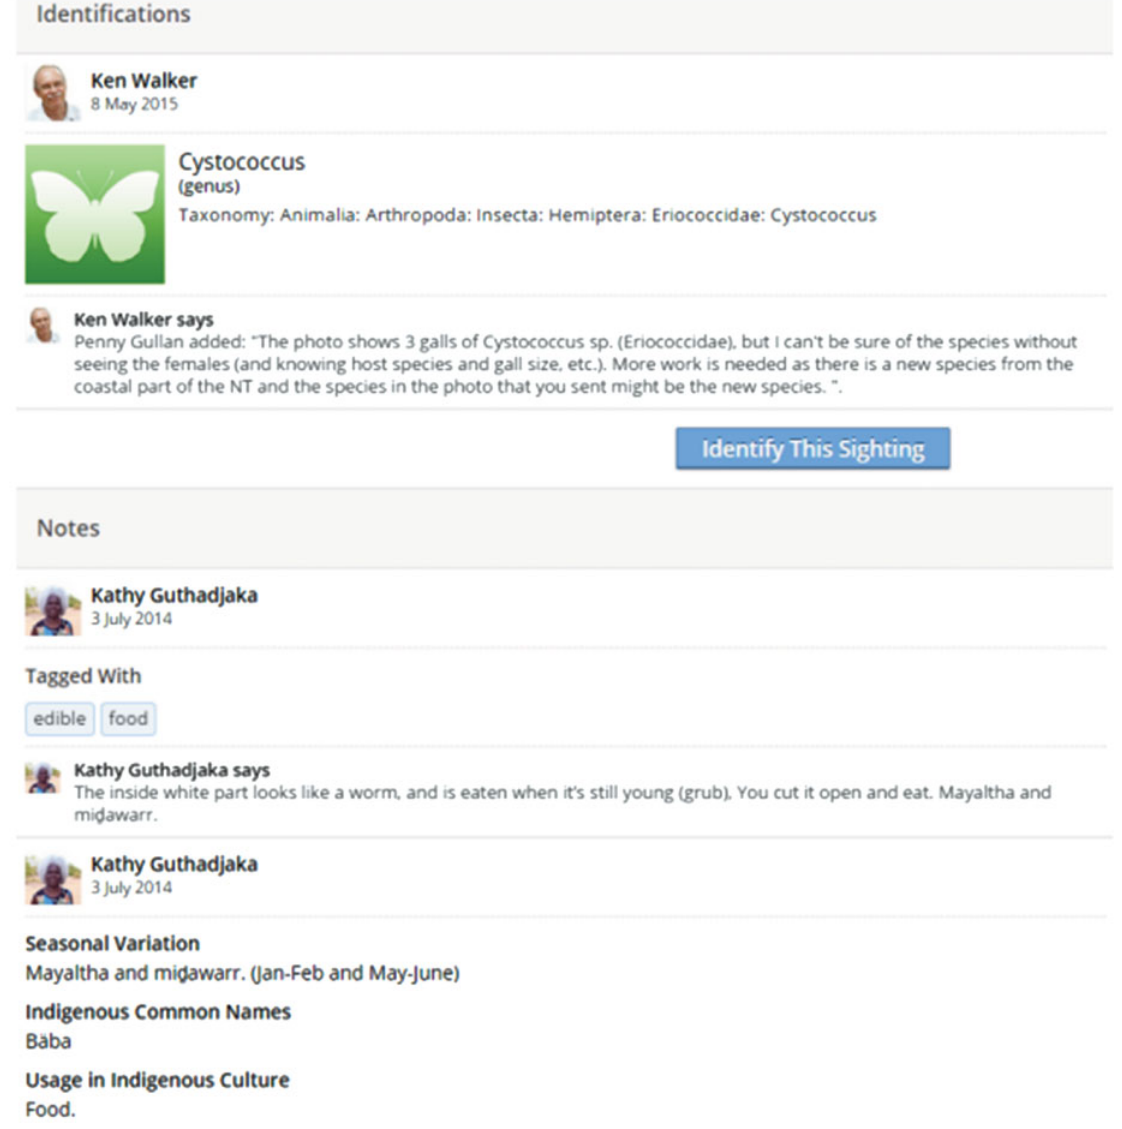
(Colour online) Taxonomy entries led to the finding that the G¨awa sighting was quite